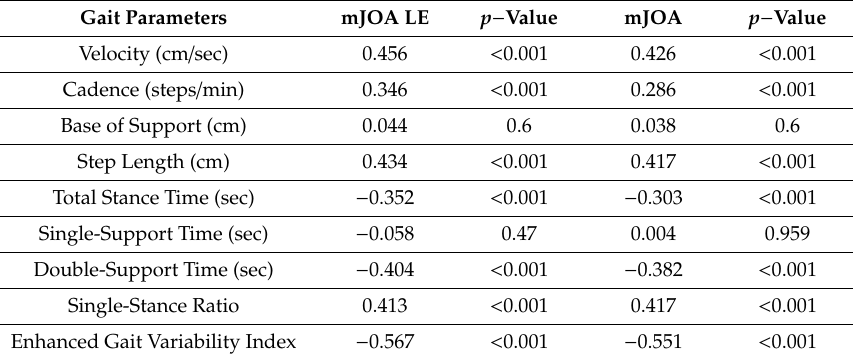
Table 4. Spearman’s rank correlation coe ffi cients between gait parameters compared with mJOA LE subscore and mJOA score (total). Confidence interval was set to